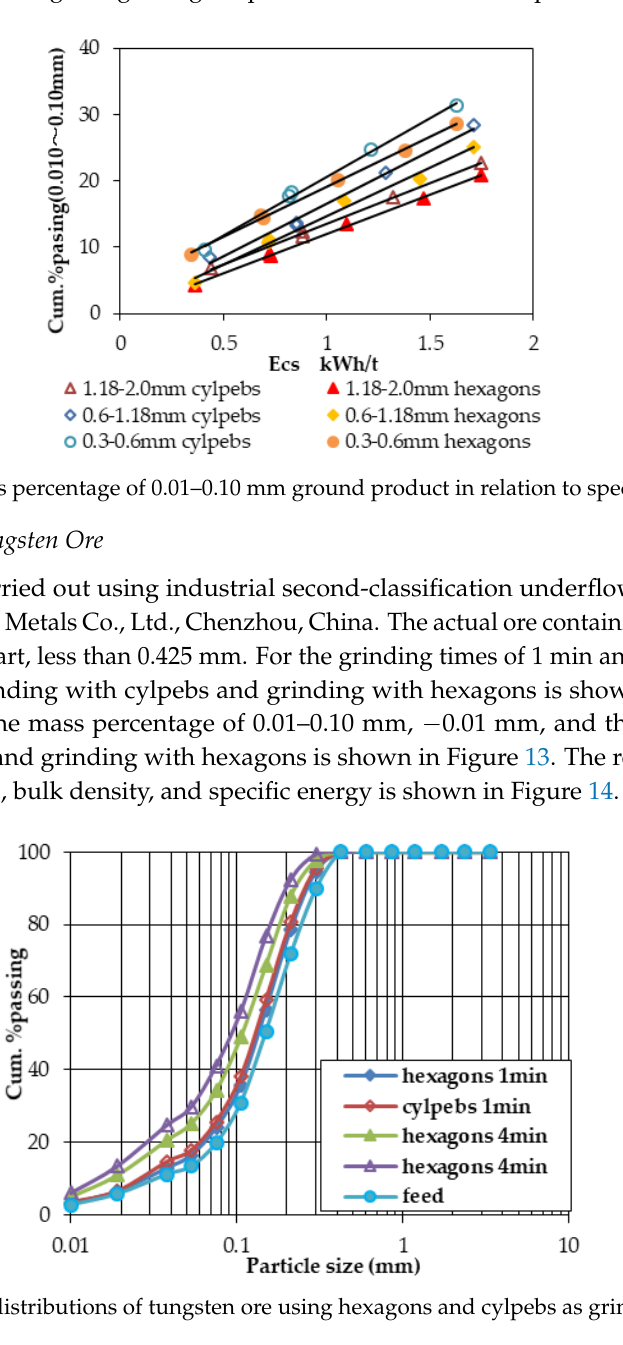
Figure 11. Mass percentage of 0.01–0.10 mm ground product in relation to specific energy.